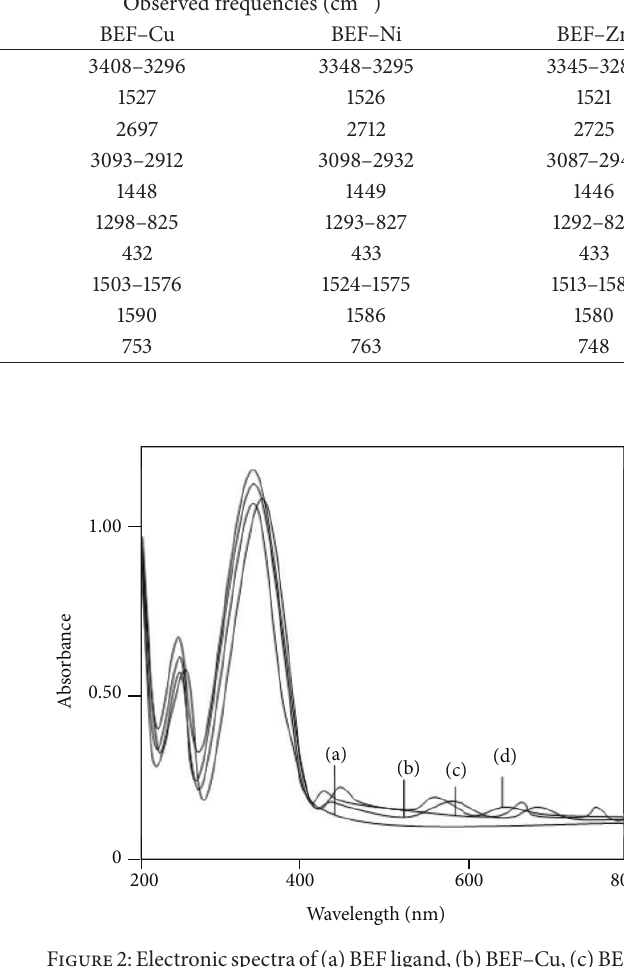
Figure2:Electronicspectraof(a)BEFligand,(b)BEF–Cu,(c)BEF– Ni, and (d)